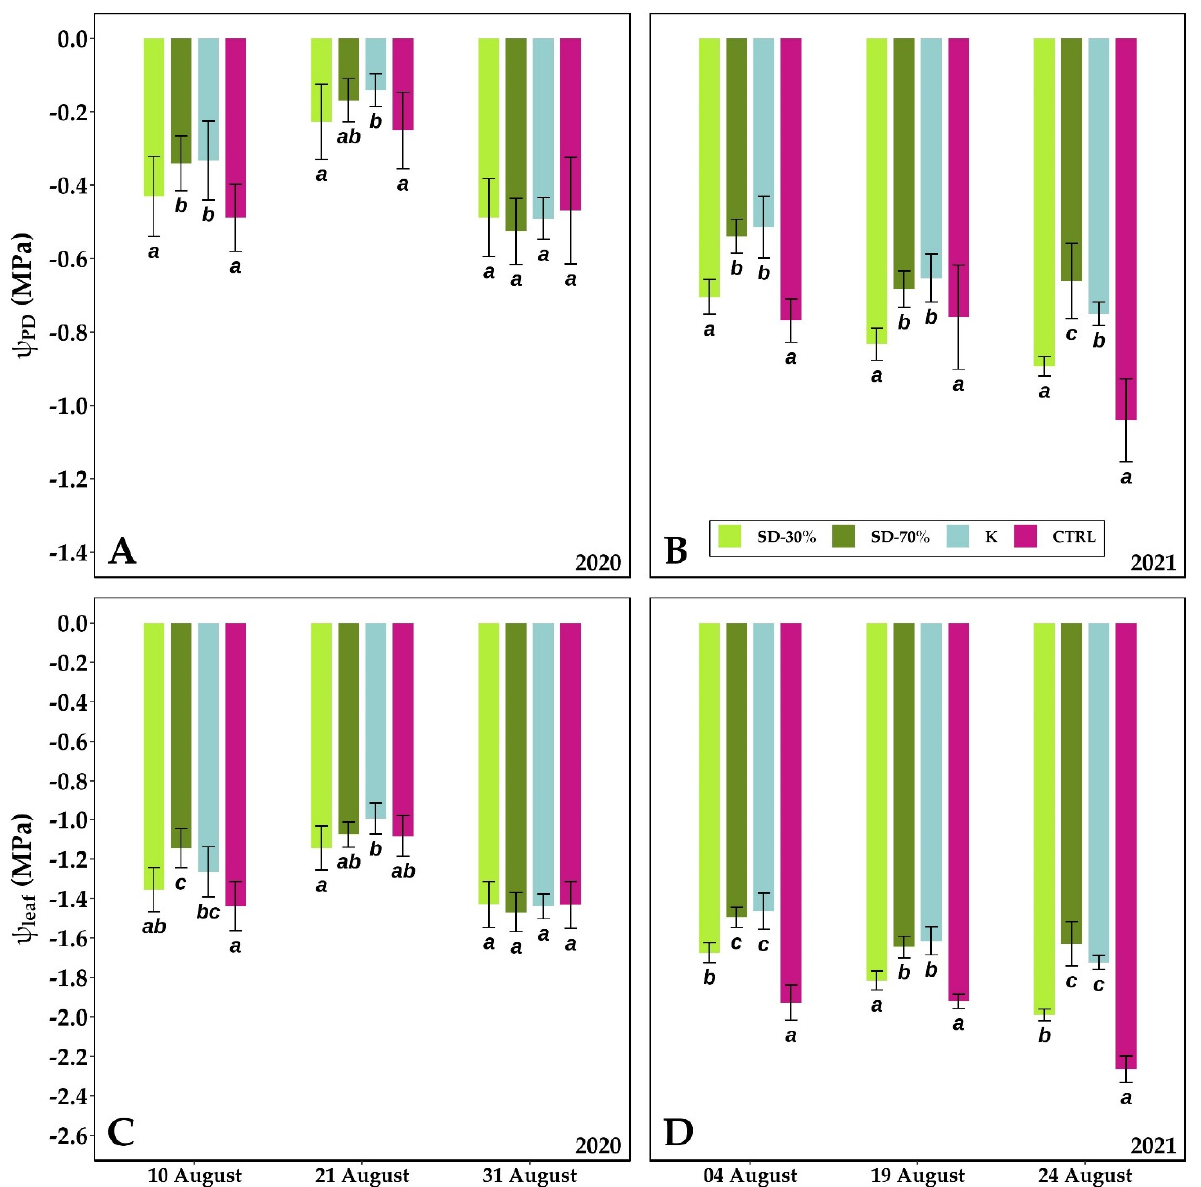
Figure 6. Pre-dawn water potential ( Ψ PD) (( A ), 2020; ( B ), 2021) and leaf water potential ( Ψ leaf) (( C ), 2020; ( D ), 2021) of Vitis vinifera with four canopy management: SD-30% (green artificial shading net at 30%; light green columns), SD-70% (green artificial shading net at 70%; dark green columns), K (kaolin; light blue columns), and CTRL (control; purple columns). Measurements were conducted at full veraison (10 August 2020 and 4 August 2021), mid maturation, berries with intermediate sugar 2021). Data (mean ± SE, n = 10) were subjected to one-way ANOVA. In each measured parameter ( Ψ PD and Ψ leaf) the statistical difference is represented by letters; within the single date, a grouping of columns, the statistical differences between the treatments (SD30%, SD70%, K, and CTRL) are represented by different letters (a, b, c) (LSD test, p ≤ 0.05). The same letter pictured on different treatments indicates no significant difference among them.